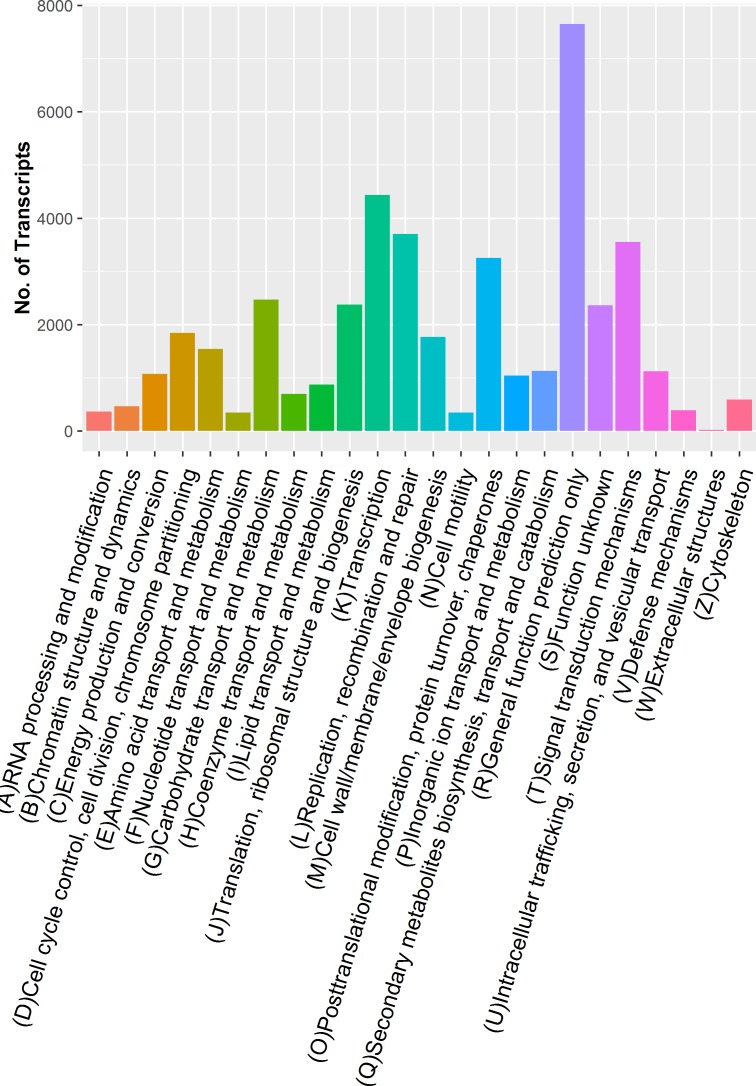
KOG classification of the putative proteins.The Y-axis indicates the number of unigenes in a specific functional cluster.